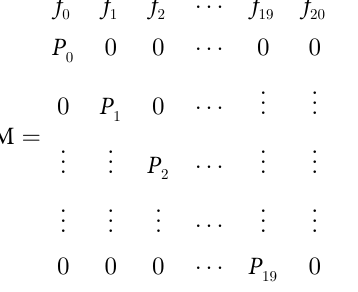
M is the population projection